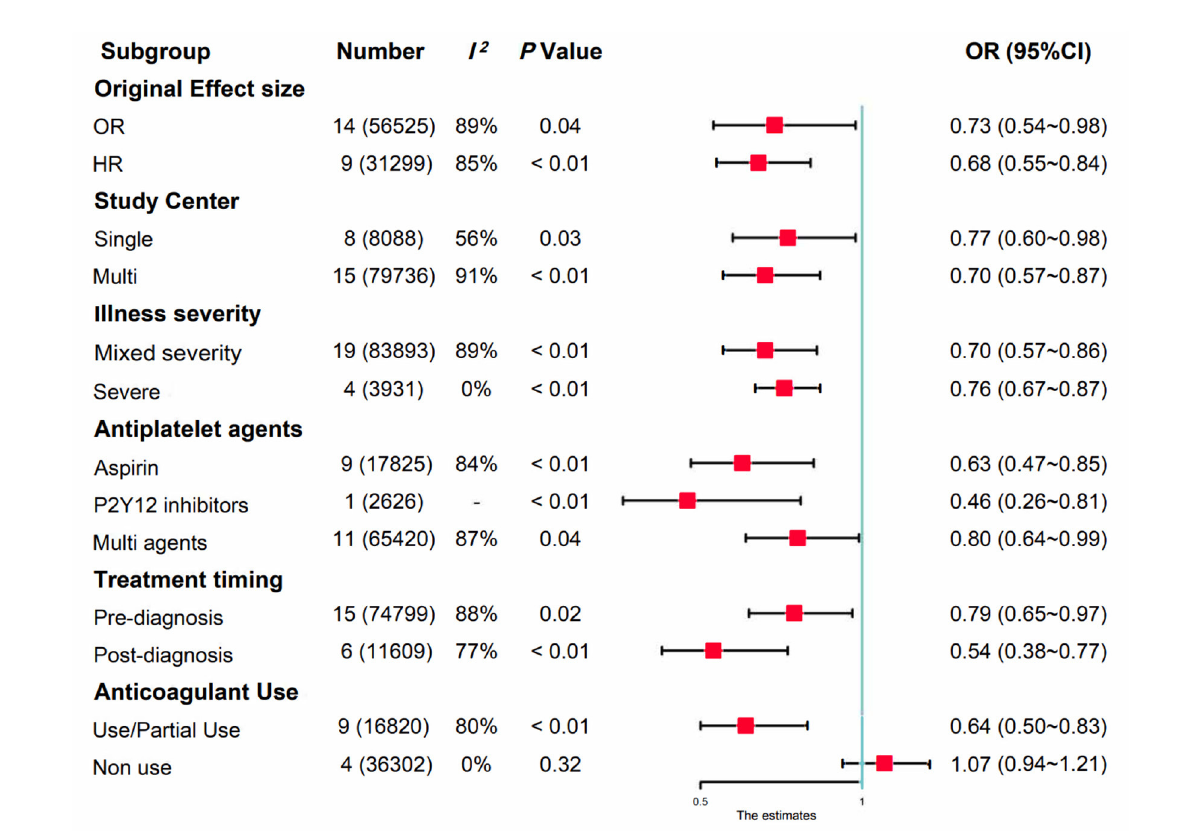
FIGURE3 Summary of the subgroup analyses in observational